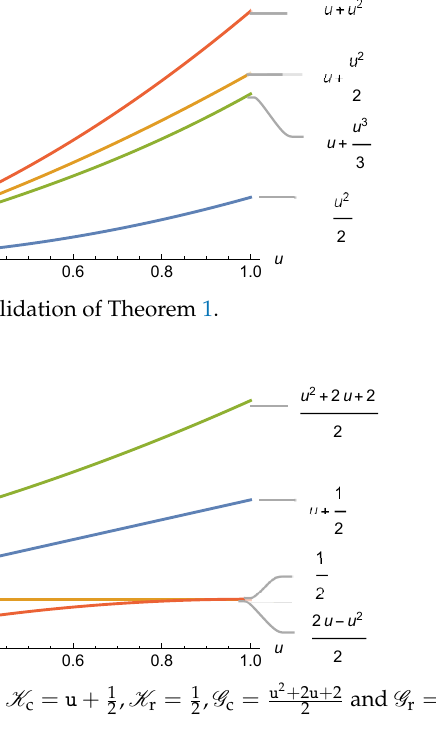
and G r = 2 u − u 2 2